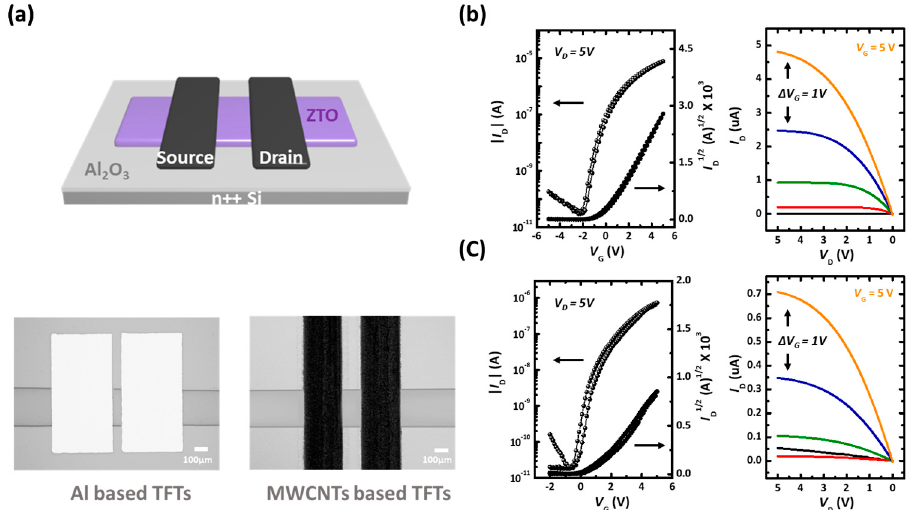
Figure 7. ( a ) Device configuration and OM images of EHD jet-printed ZTO. The transfer and output characteristics of ZTO devices with ( b ) Al and ( c ) MWCNTs S/D electrodes.